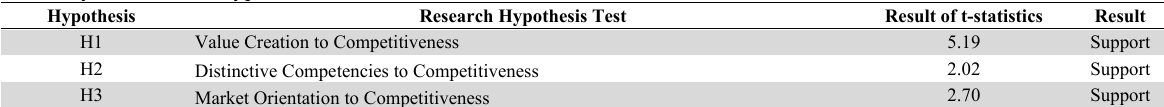
Summary of Research Hypothesis